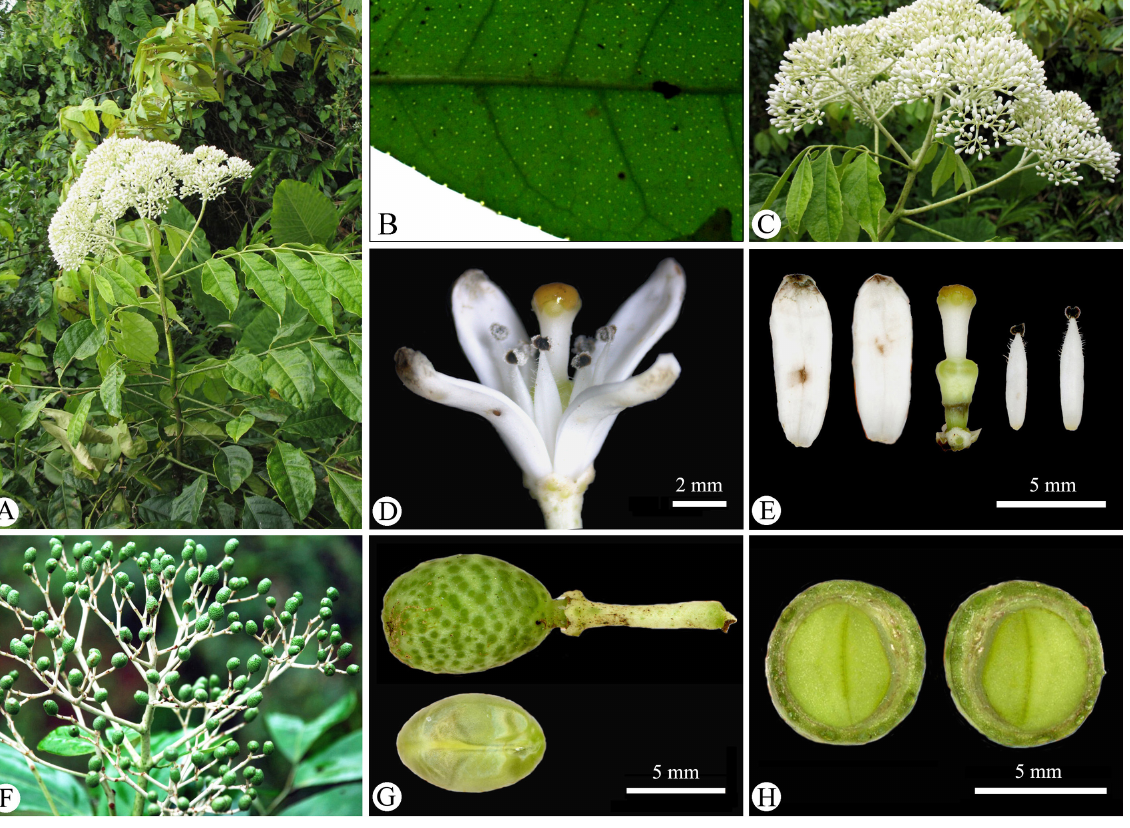
Fig. 6. Bergera glabra (Guillemin) F.J.Mou comb. nov. A . Plant. B . Leaf. C . Inflorescence. D . Flower. E . Flower parts. F . Infructescence. G . Fruit. H . Seeds. Photos taken by Tran The Bach and Dr Truong in